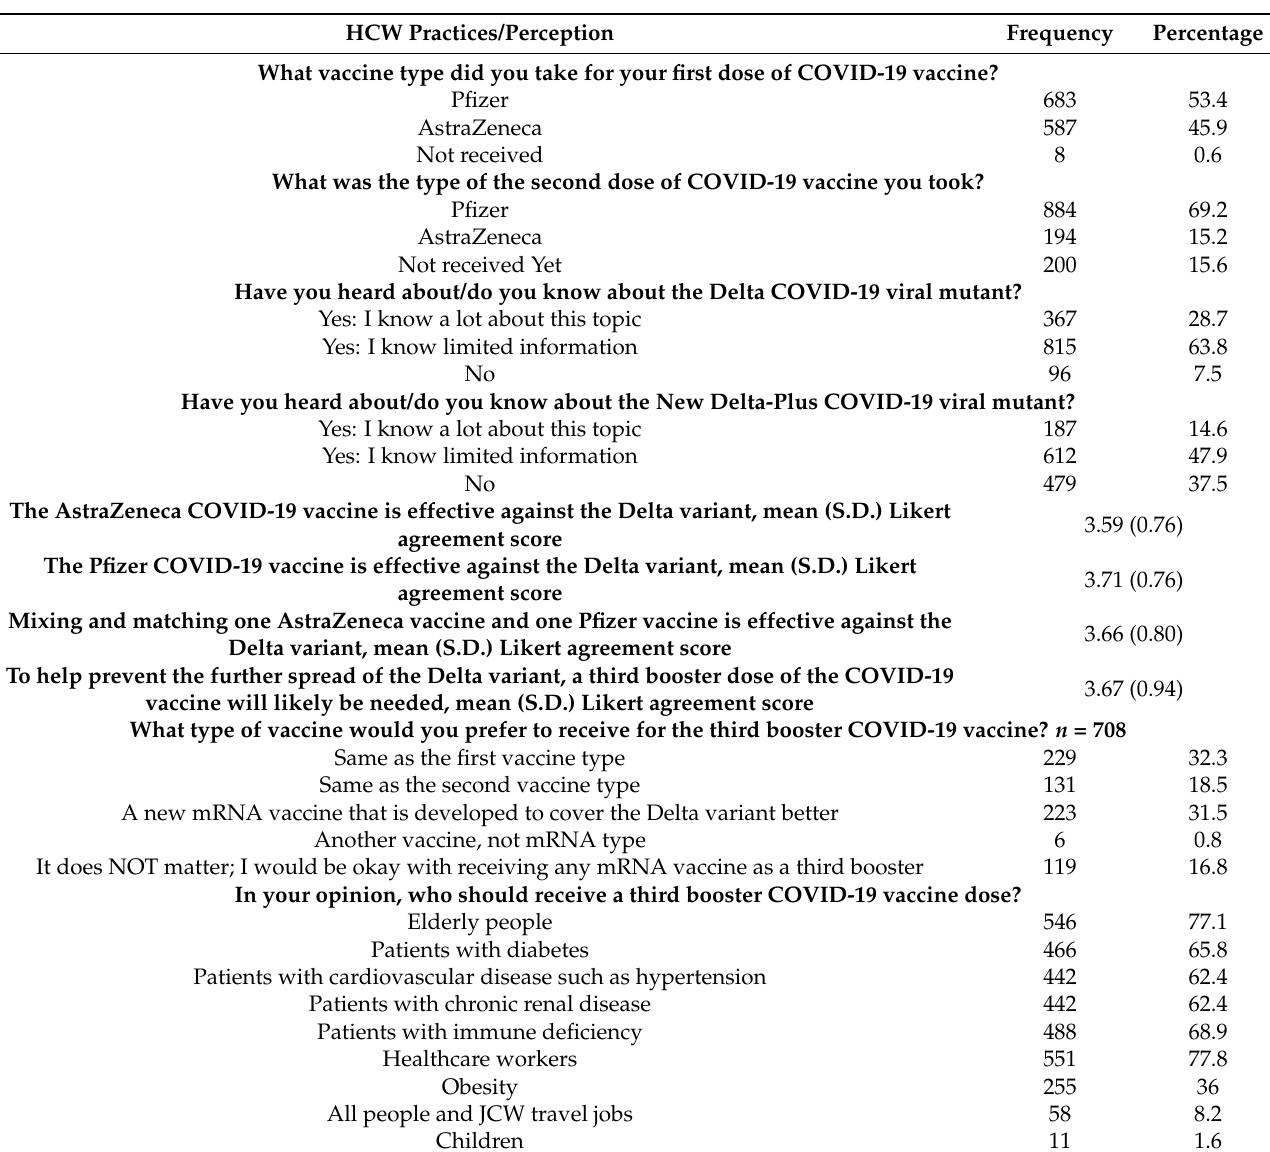
Table 3. Descriptive analysis of the respondents’ perceptions and practices relating to the COVID-19 vaccine and their perceptions and practices relating to the Delta